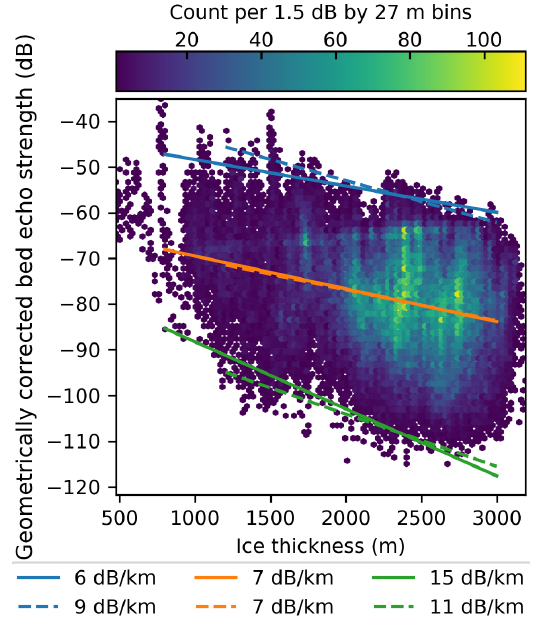
Figure 2. Attenuation determination. The color field represents the number of observations in each 1.5dB geometrically corrected echo strength by a 27m thickness bin. The solid lines are regressions using observations with ice thickness greater than 800m and the dotted lines greater than 1200m. The orange lines use all observa- tions in each thickness bin. The blue lines use the five highest echo strengths in each thickness bin, and the green line uses the five low- est. The legend reports the regression